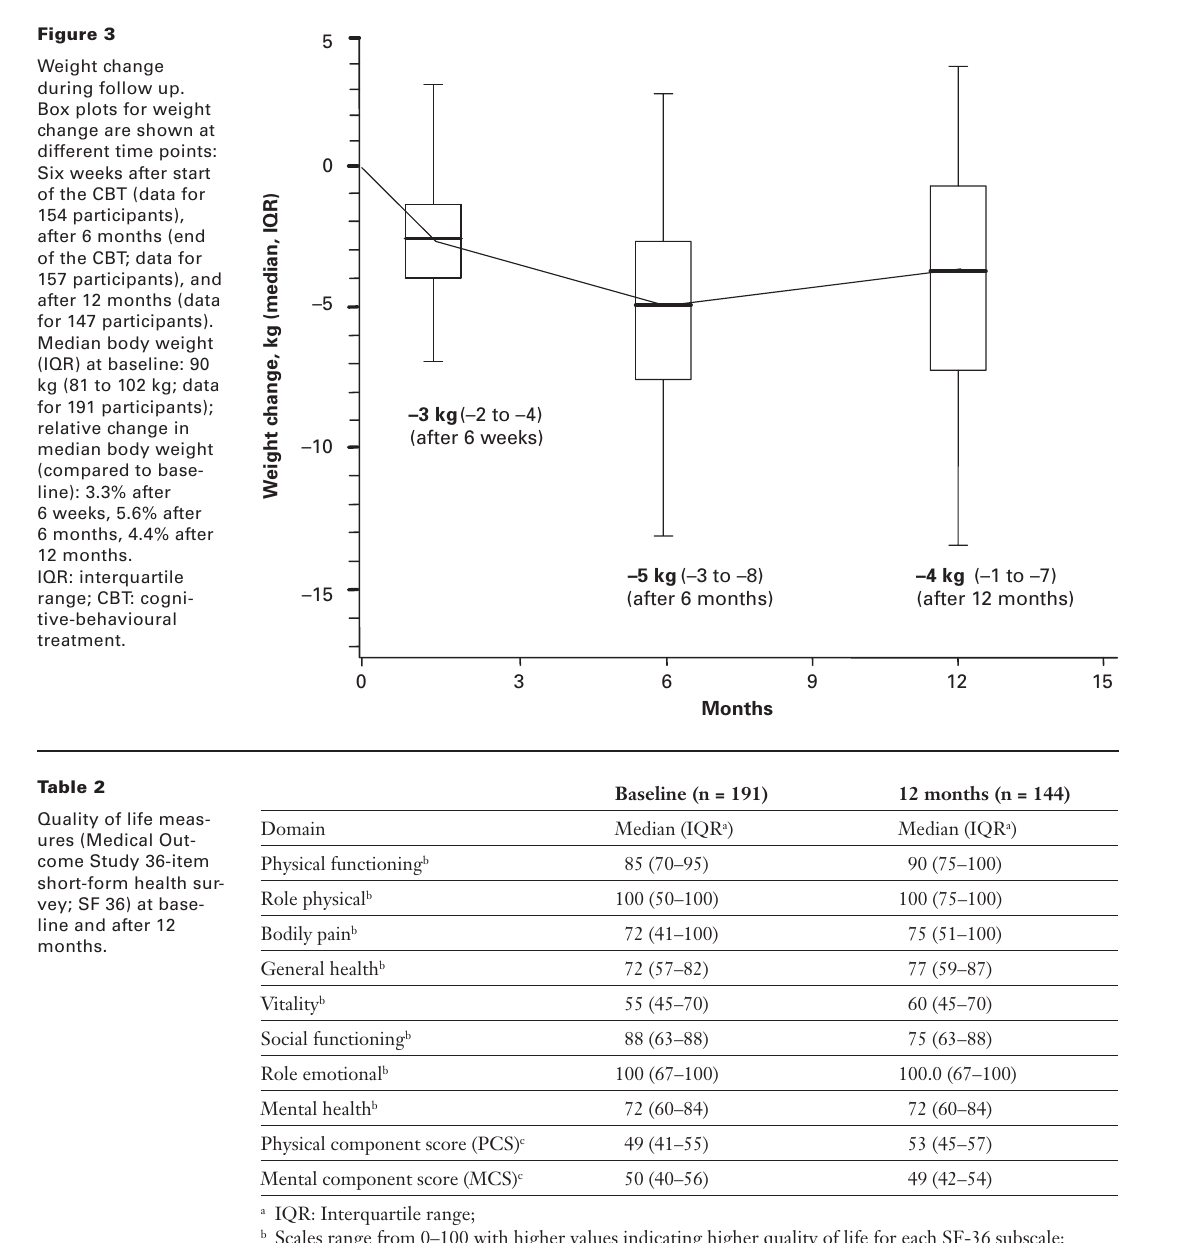
Figure 3 Weight change during follow up.